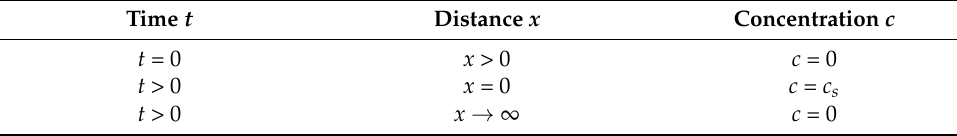
Table 1. Initial and boundary conditions of diffusion